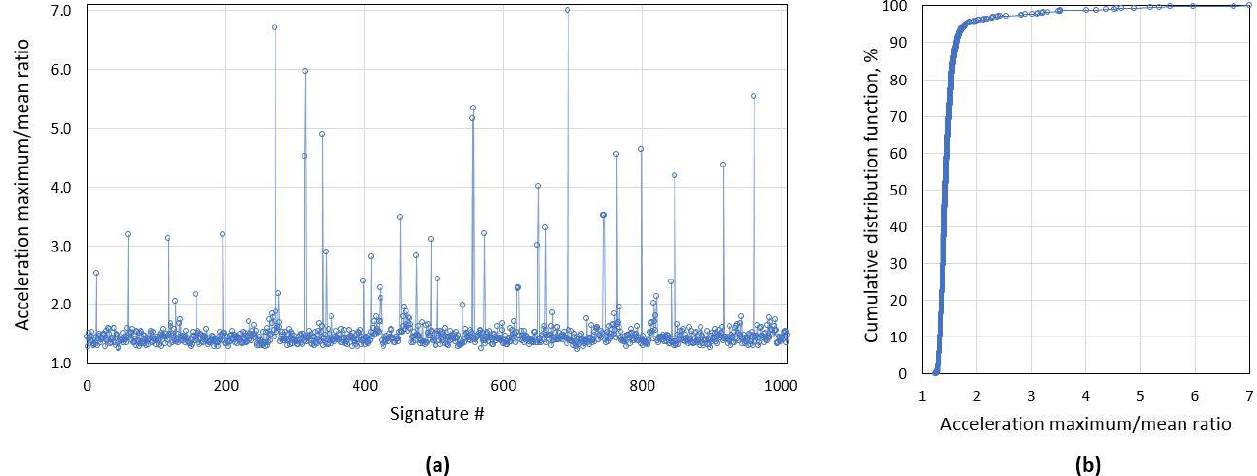
Figure 2. ( a ) Accelerometer maximum/mean value ratio distribution for the current test group of 1000 unique signatures with ( b ) cumulative distribution function (CDF). As it is visible, 95.7 % of all cases has a ratio below 2.